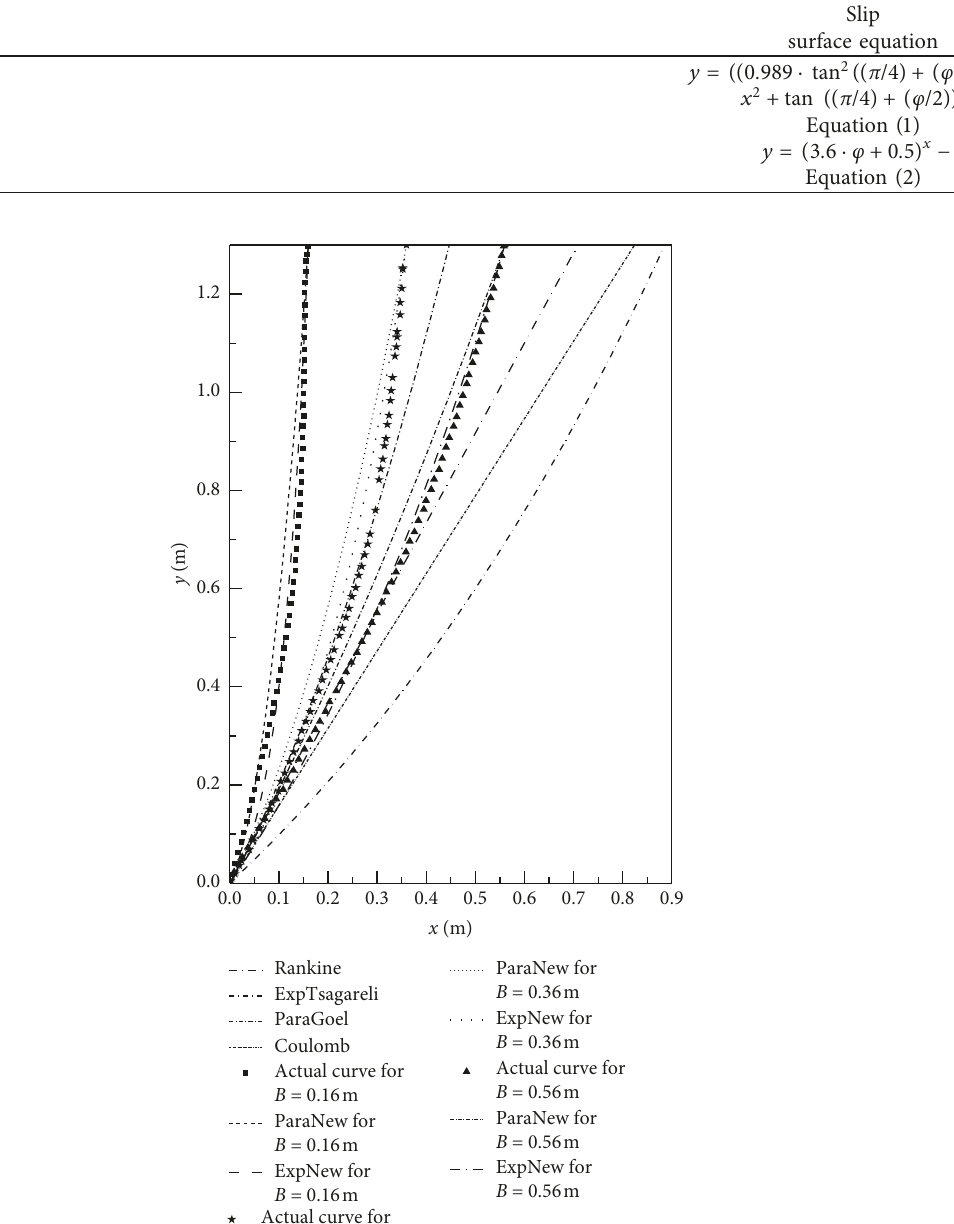
Table 3: Formulas of compared slip